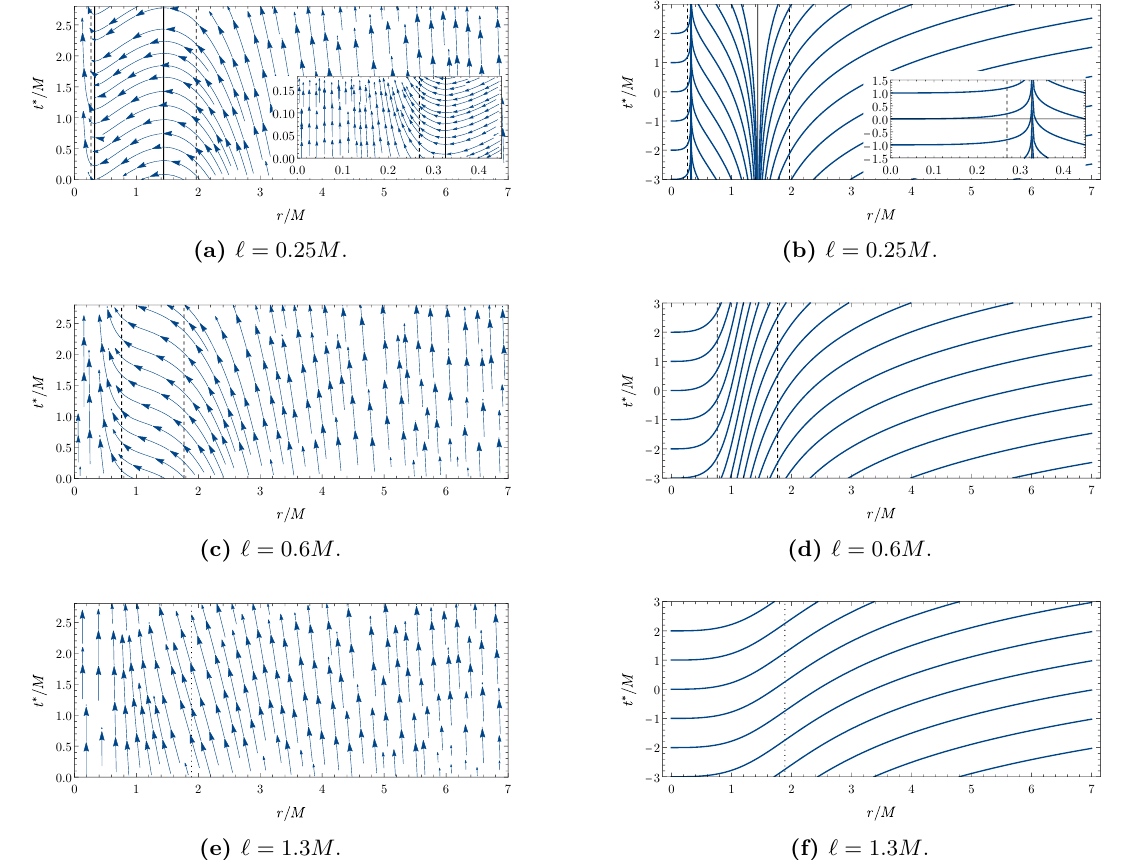
Figure 2. Hayward non-singular black hole: æther flow (left) and constant-khronon surfaces (right). Black solid lines mark universal horizons, dashed lines Killing horizons; the dotted line signals the star’s effective radius. The first row depicts the case with outer and inner KHs and UHs, the middle row the case with only two KHs, the bottom row the case of an ultracompact, horizonless, object. The insets are a zoom-in to the small- r